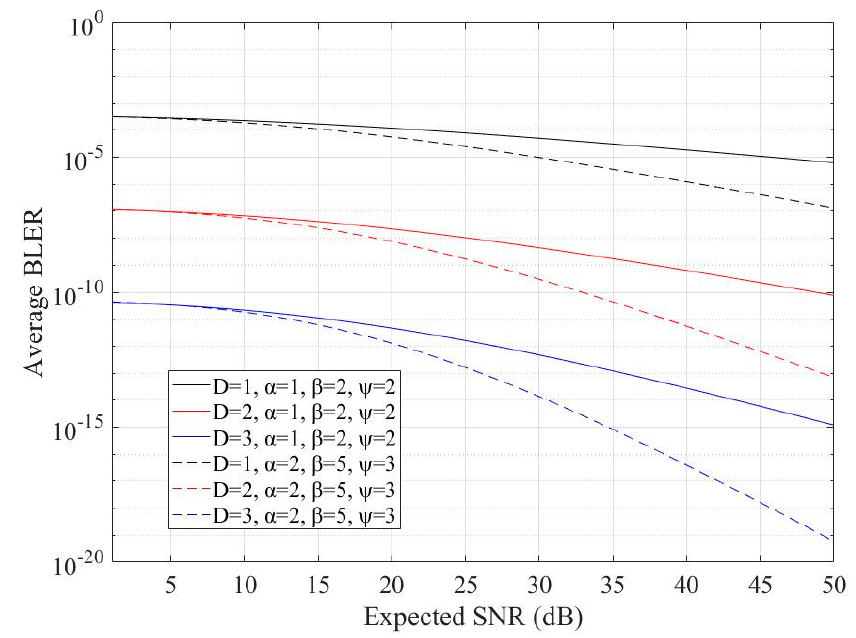
Figure 4. ABLER performance versus the expected SNR for M = 4, N = 5, and 8-PAM scheme.